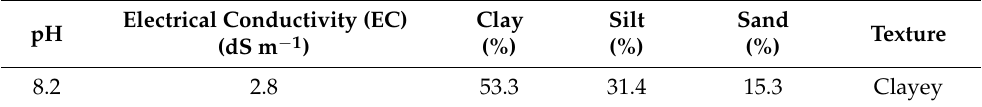
Table 1. Some physical and chemical properties of